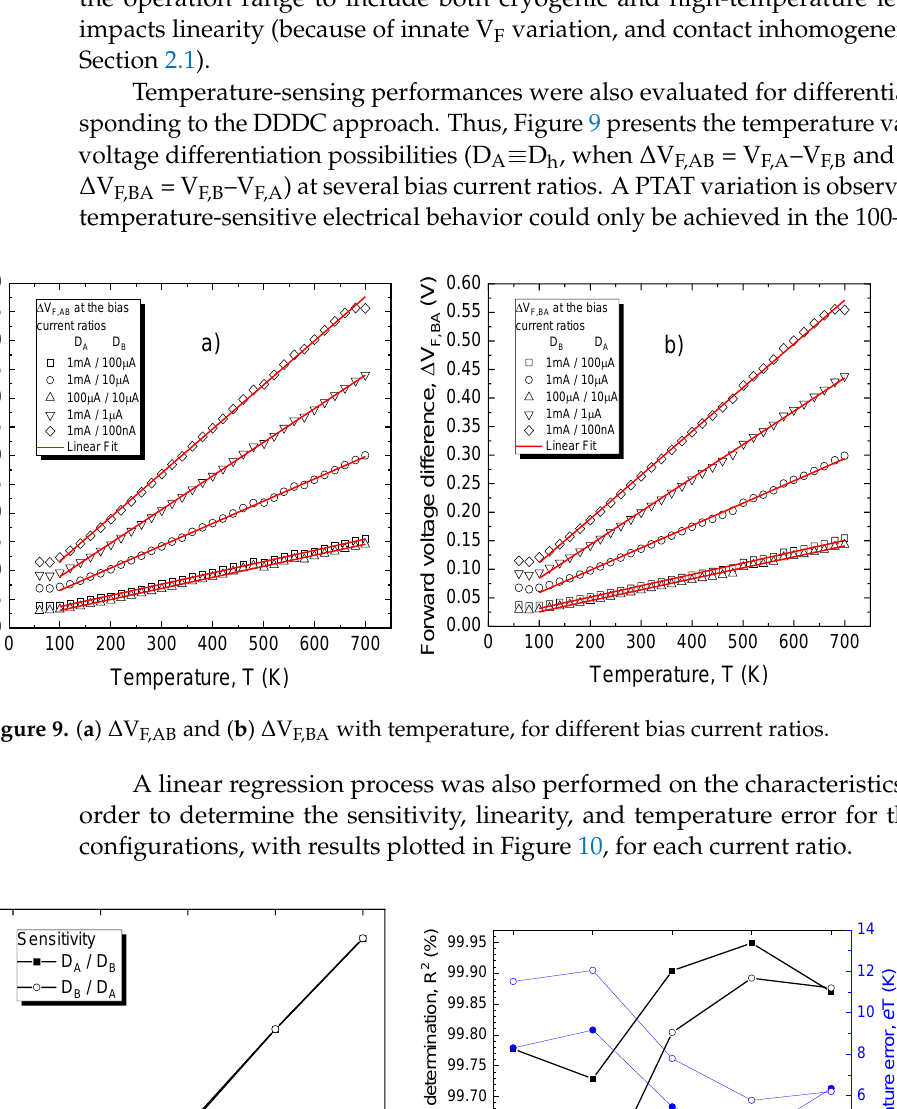
Figure 8. ( a ) Sensitivity, ( b ) coefficients of determination and average temperature error for both